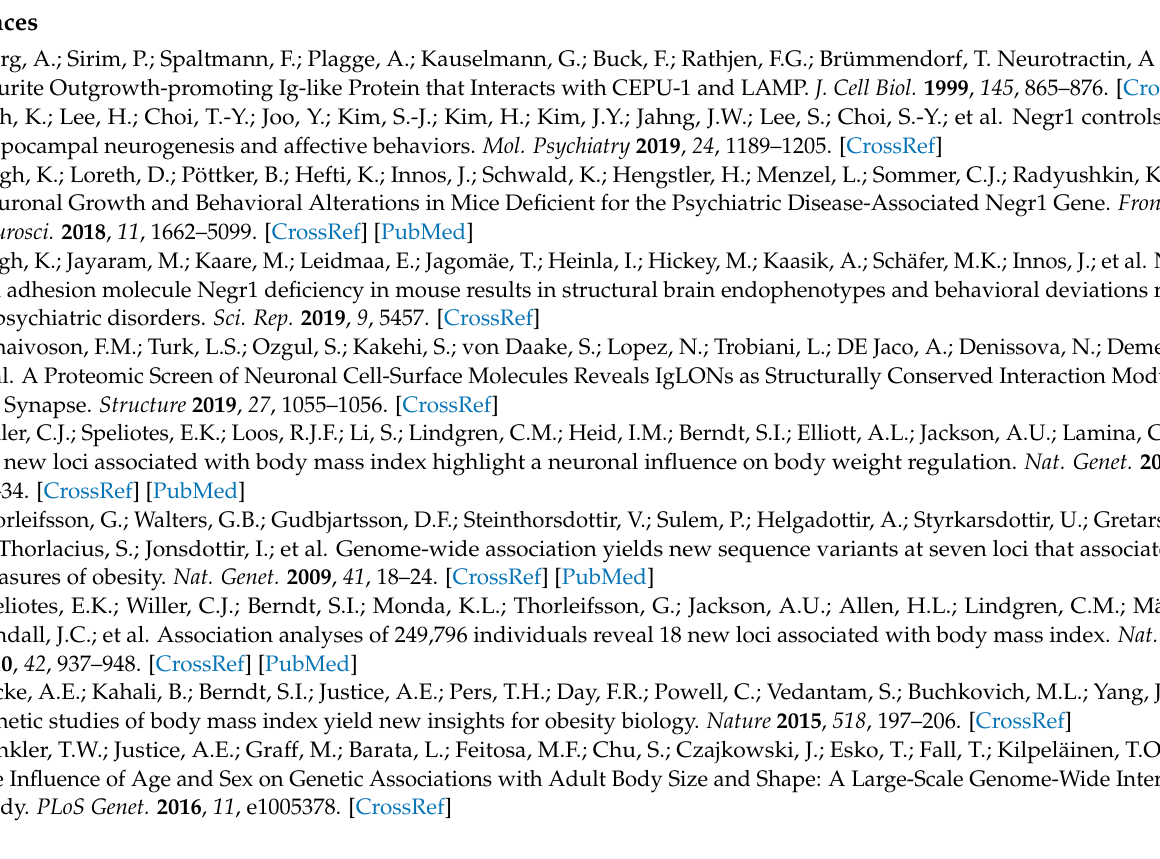
The levels of selected organic acids, Figure S3: BODIPY stainings of male liver, Figure S4: BODIPY staining of female liver, Figure S5: BODIPY stainings of female liver, Figure S6: Cross-sectional area of muscle fibers from female mice, Table S1: Metabolites, Table S2: Organic